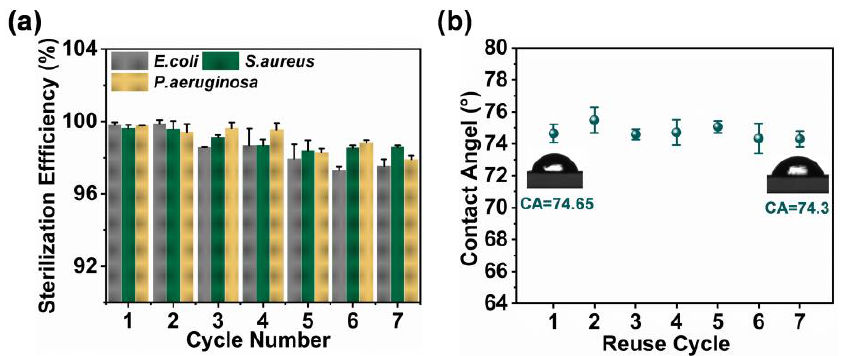
Figure 9. ( a ) Killing efficiencies of the ZIF – 8/PDA/PAN composite membrane on E. coli , S. aureus , and P. aeruginosa in 7 cycles; ( b ) changes in the surface CA of the ZIF – 8/PDA/PAN composite membrane after 7 cycles of use.